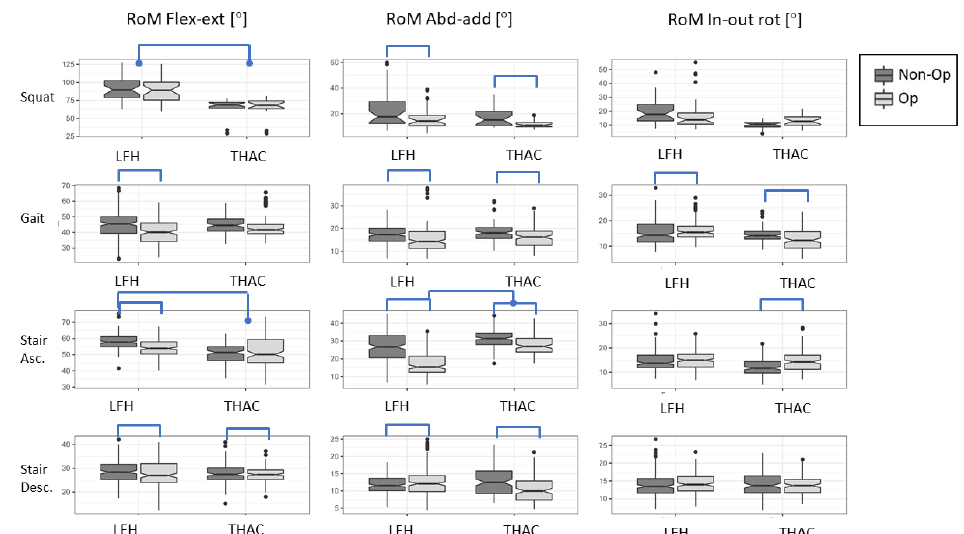
Figure 3. The boxplots illustrate range of motion (RoM) in the operated hips (light grey) and non-operated hips (dark grey) within the group with a total hip replacement (THAC) and the group with resurfaced hip design (LFH). Significant differences are marked in each graph, based on the statistical tests, between groups (brackets with end points) and between sides (simple brackets). Table 3. Group estimated mean and standard error (SE) of the range of motion (RoM) for the healthy controls (CTRL), the conventional hip replacement group (THAC) and the large femoral head (LFH) design group. “FE” = flexion-extension; “Abd-Add” = abduction-adduction; “Rot” = inward-outward rotation and “ num ” = number of observations (i.e., squat 23 participants x 4 cycles; gait and stair walking 23 participants × 5 trials × 4 cycles). The estimated group di ff erences are given in cursive text. Post hoc tests were performed if a significant group di ff erence was found.